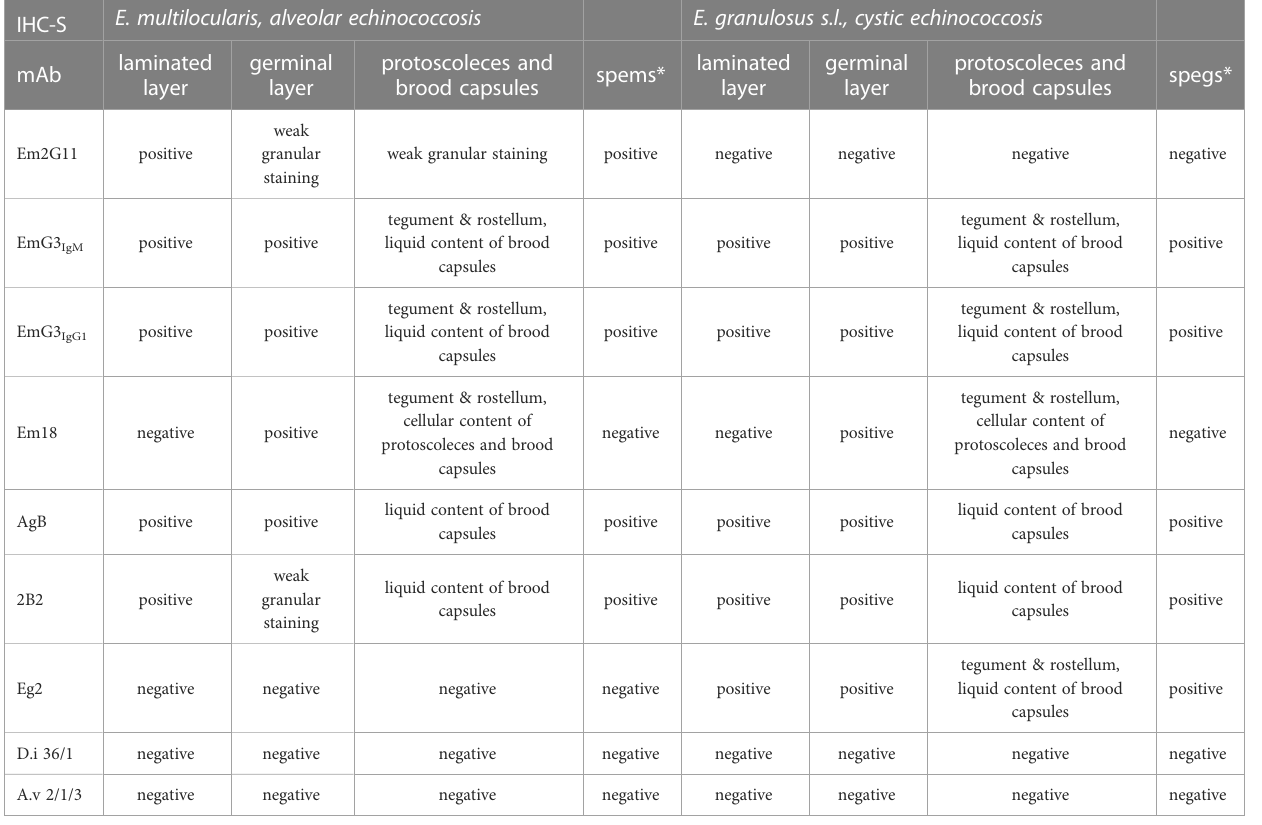
*spems and spegs: Small particles of E. multilocularis and E. granulosus . Spems and spegs are antigenic particles that are stained in the surrounding tissue of the parasite lesions (Reinehr et al., 2020; Ricken et al., 2017) and in bordering lymph nodes (Grimm et al.,